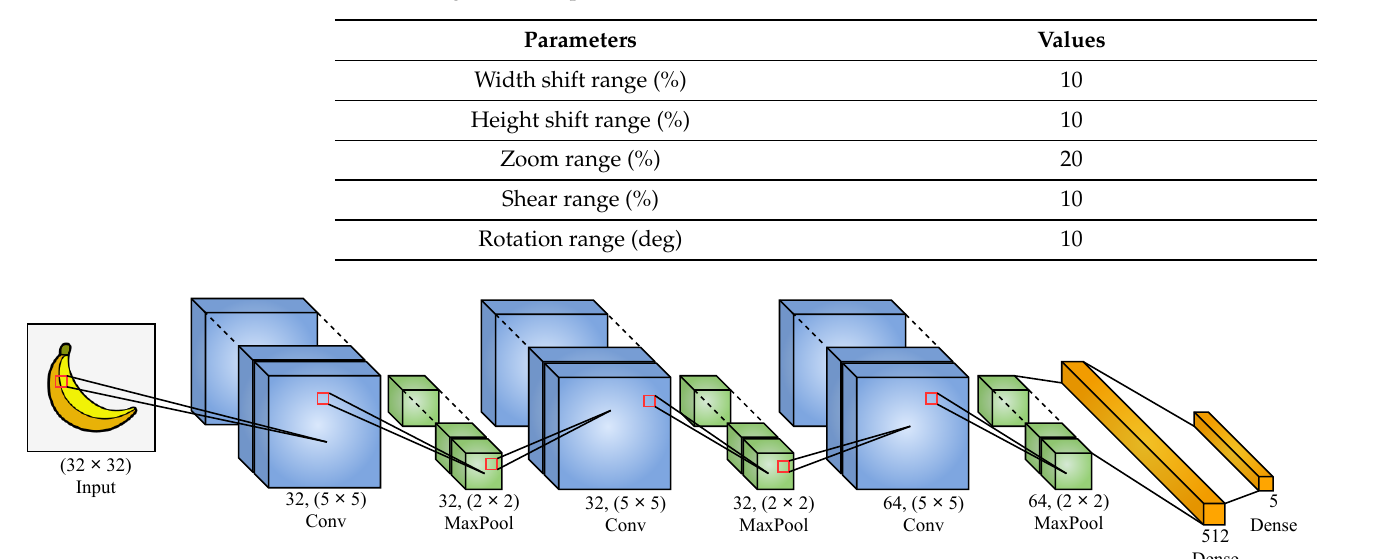
Table 3. Augmentation parameters.